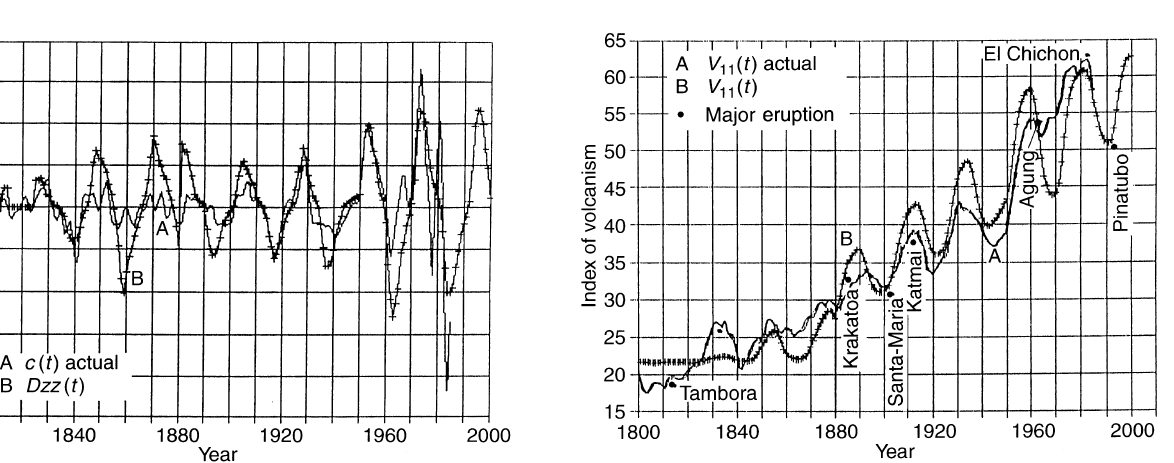
Fig. 18. Volcanism and ‘‘groomed’’ solar signal 3